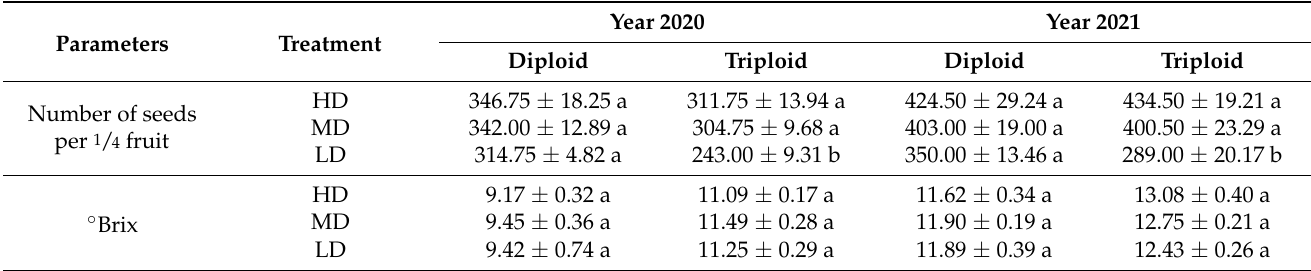
Table 5. Number of seeds in 1/4 of the fruit and soluble solids content ( ◦ Brix) in diploid and triploid watermelon cultivars for both years for the three treatments (release density: HD, MD, and LD).